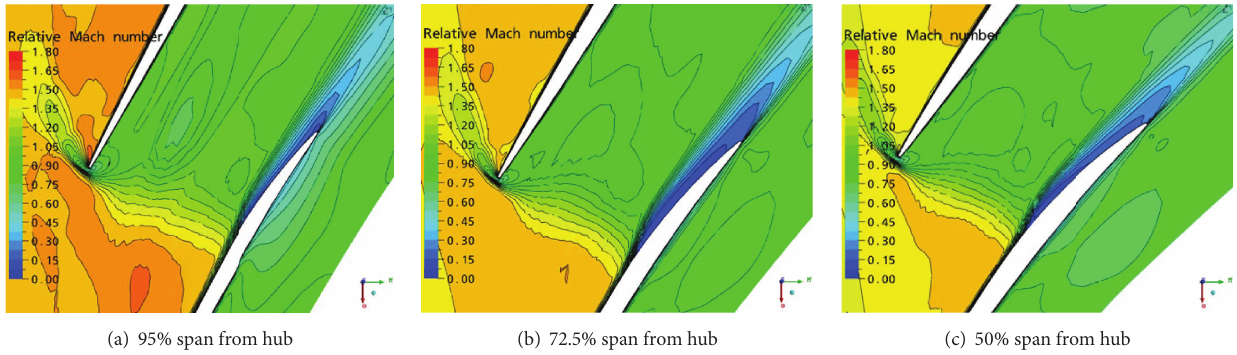
Figure 10: Relative Mach number distribution in the blade passage of baseline rotor at three spanwise locations from hub (100% design rotational speed, near-design mass flow